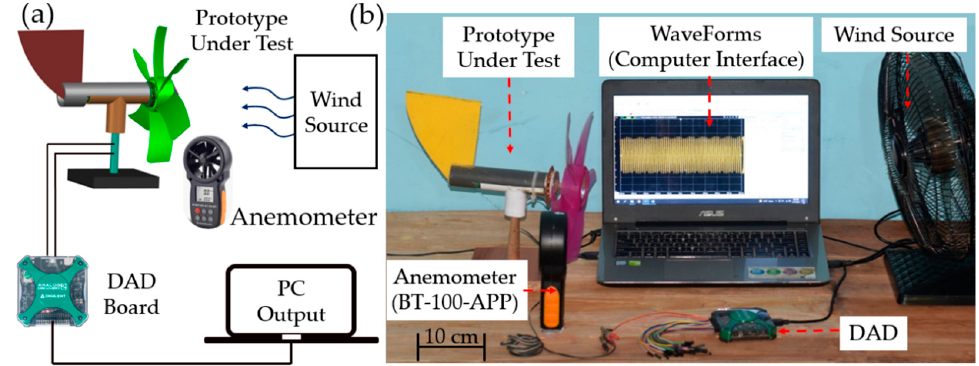
Figure 4. ( a ) Schematic of the experimental setup and ( b ) photograph of the experimental characterization of the EMWEH prototype.